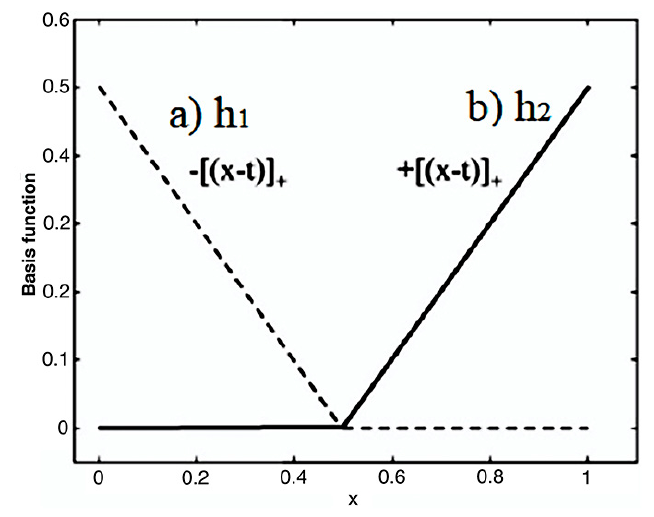
Figure 4. Basis functions diagram ( a ) h1 and ( b ) h2 values.